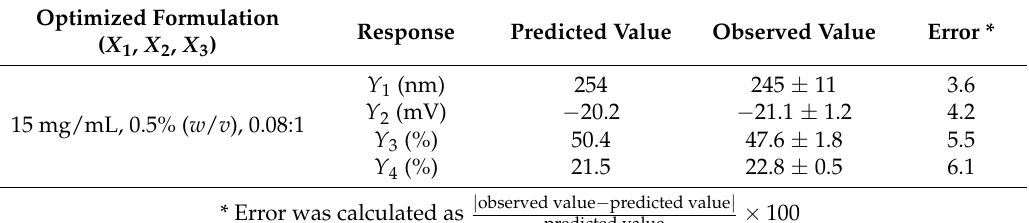
Table 4. Comparison of the observed and predicted responses of the optimized Cur-CS/Alg NP